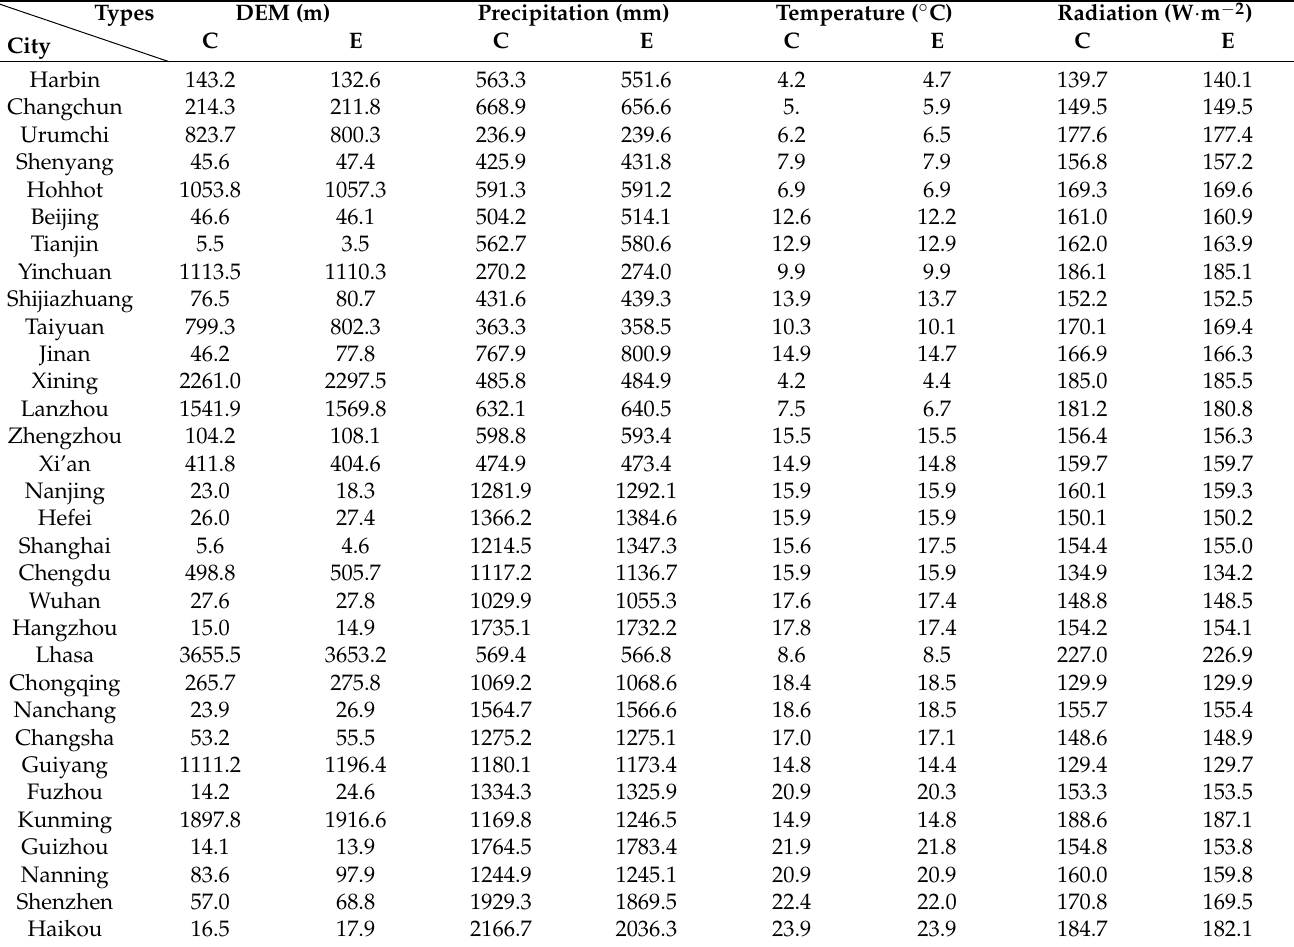
Table 1. Average temperature, altitude, precipitation, and radiation of 32 major cities in